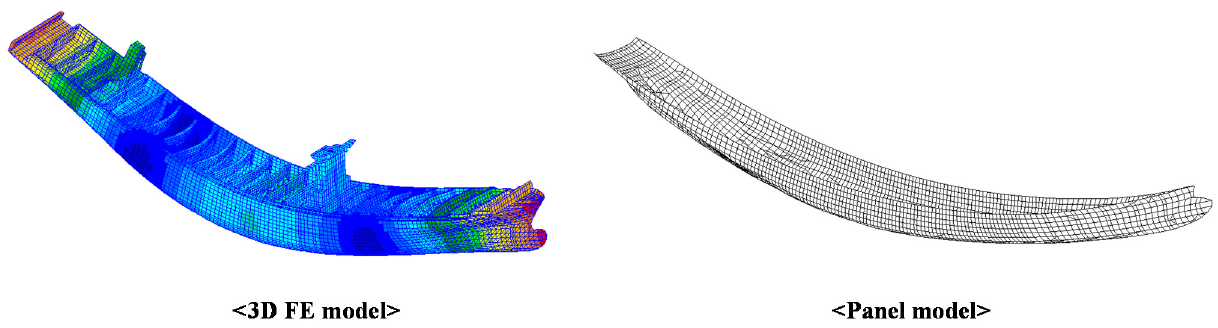
Figure 5. Mapping of eigenvectors using linear interpolation.